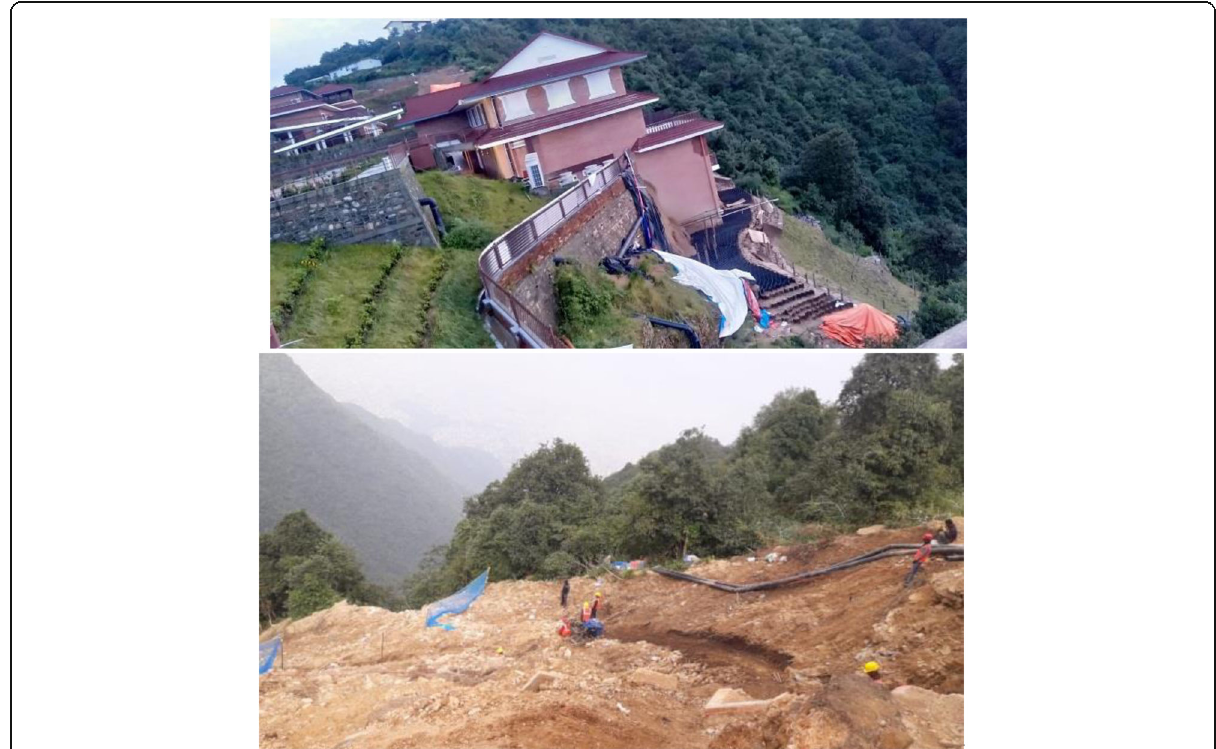
Fig. 3 Four stories building and landslide in the slope just below the